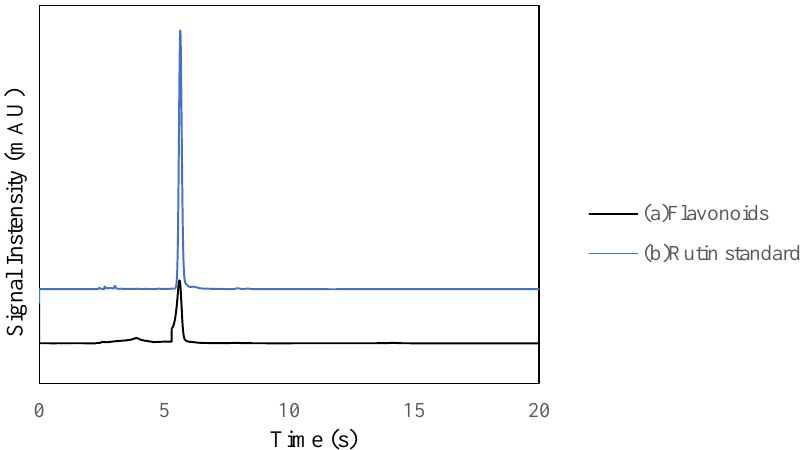
Figure 5. The high-performance liquid chromatography of ( a ) flavonoids and ( b ) the rutin standard.